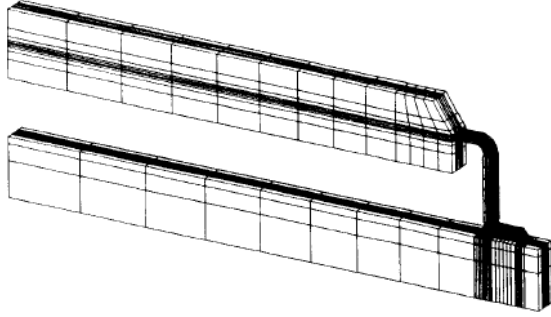
Fig. 2. Example of a detailed model of a QFP component that uses symmetry to simplify the modelling process and reduce solution time [36].